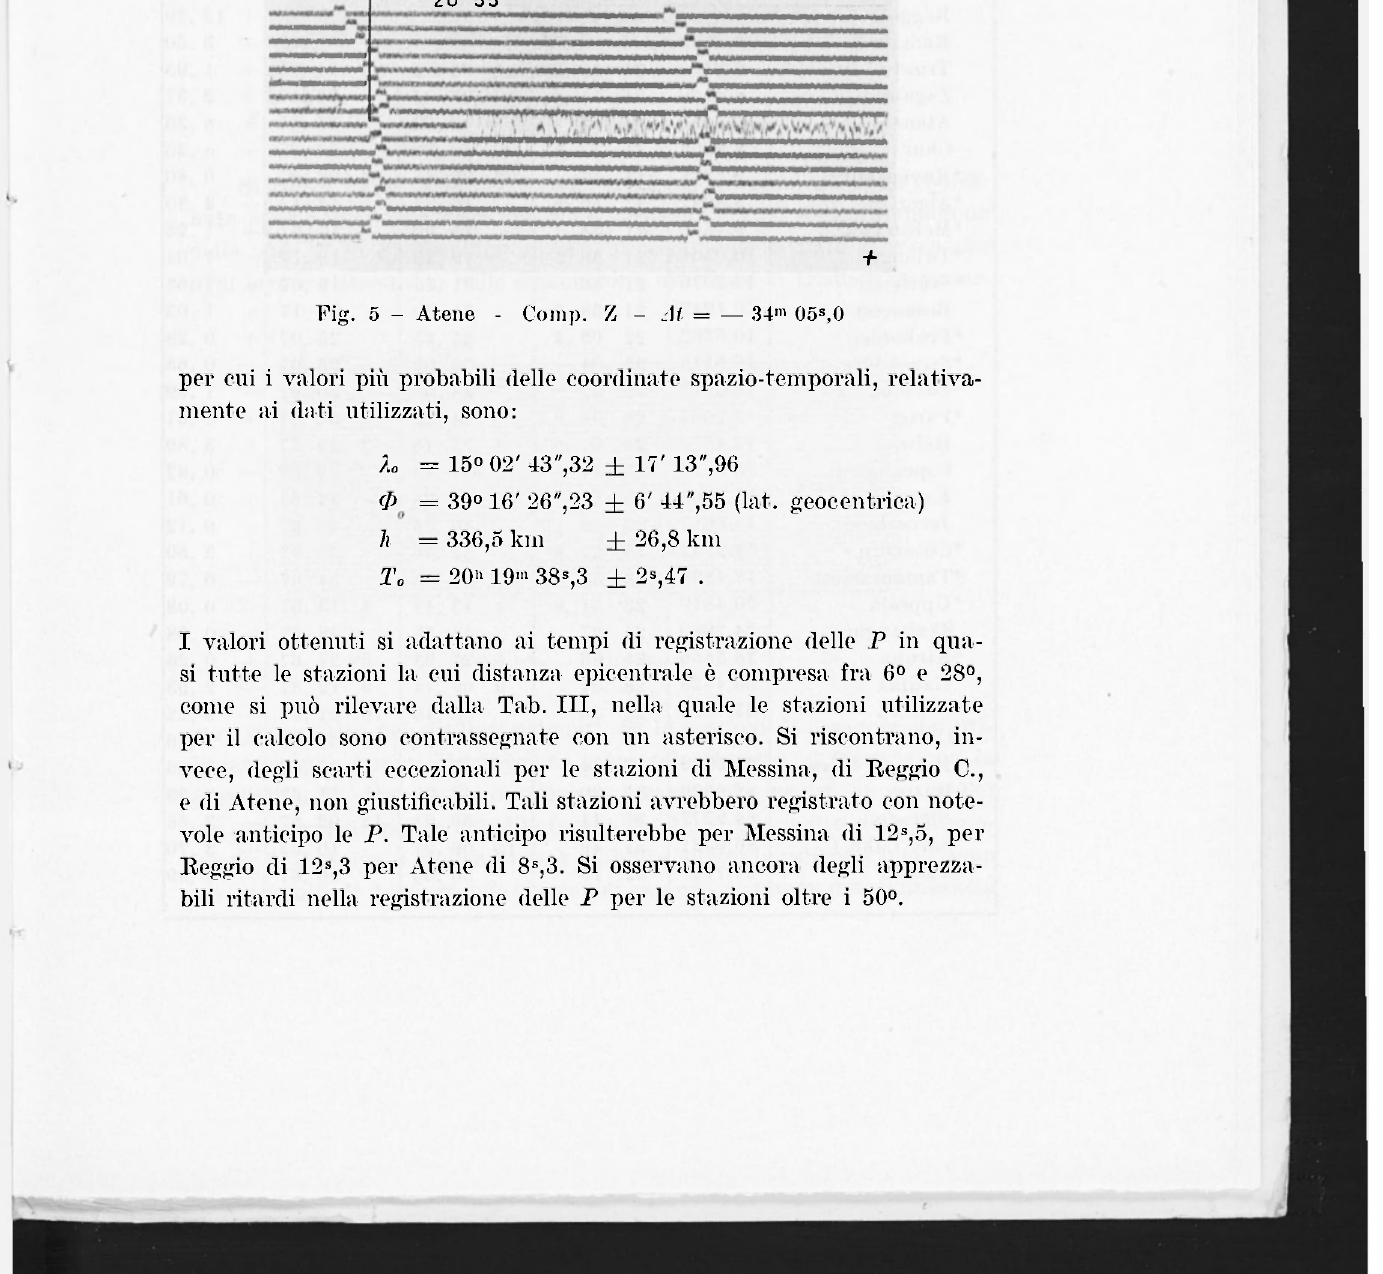
Fig. 5 - Atene - Comp. Z - At = — 34 m 05 s